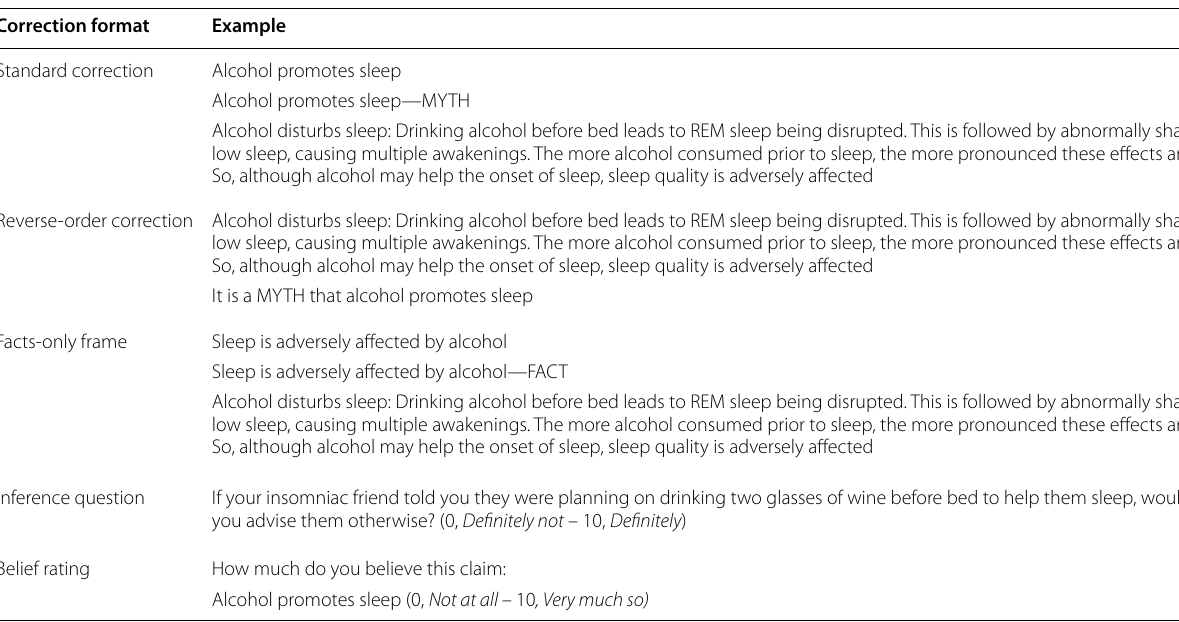
Table 2 Example of a correction in standard format, reverse‑order format, and facts‑only frame, as well as an example inference question and belief